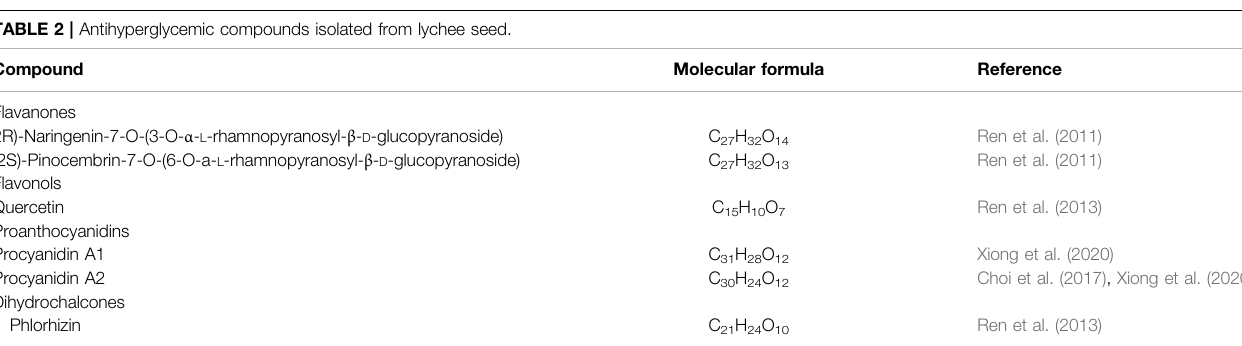
TABLE 2 | Antihyperglycemic compounds isolated from lychee seed.